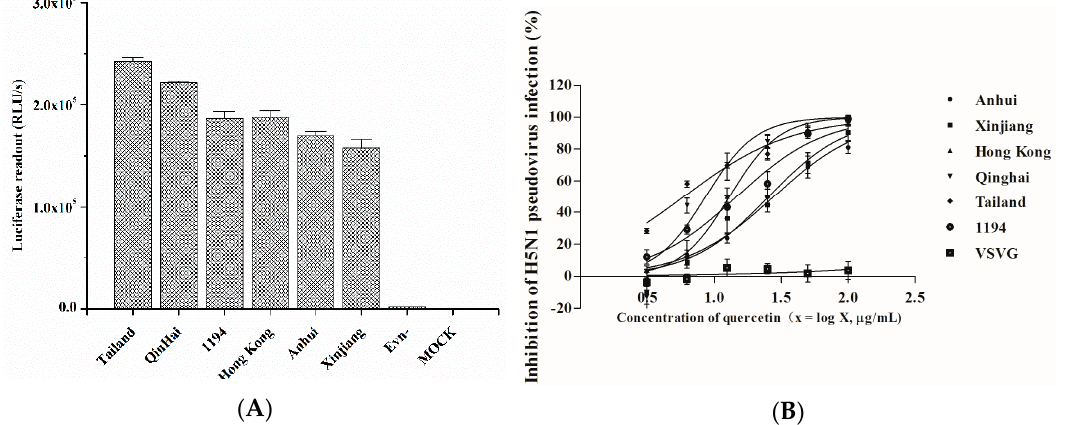
Figure 7. The inhibitory activity of quercetin on H5N1 pseudovirus infection. ( A ) Infectivities of a